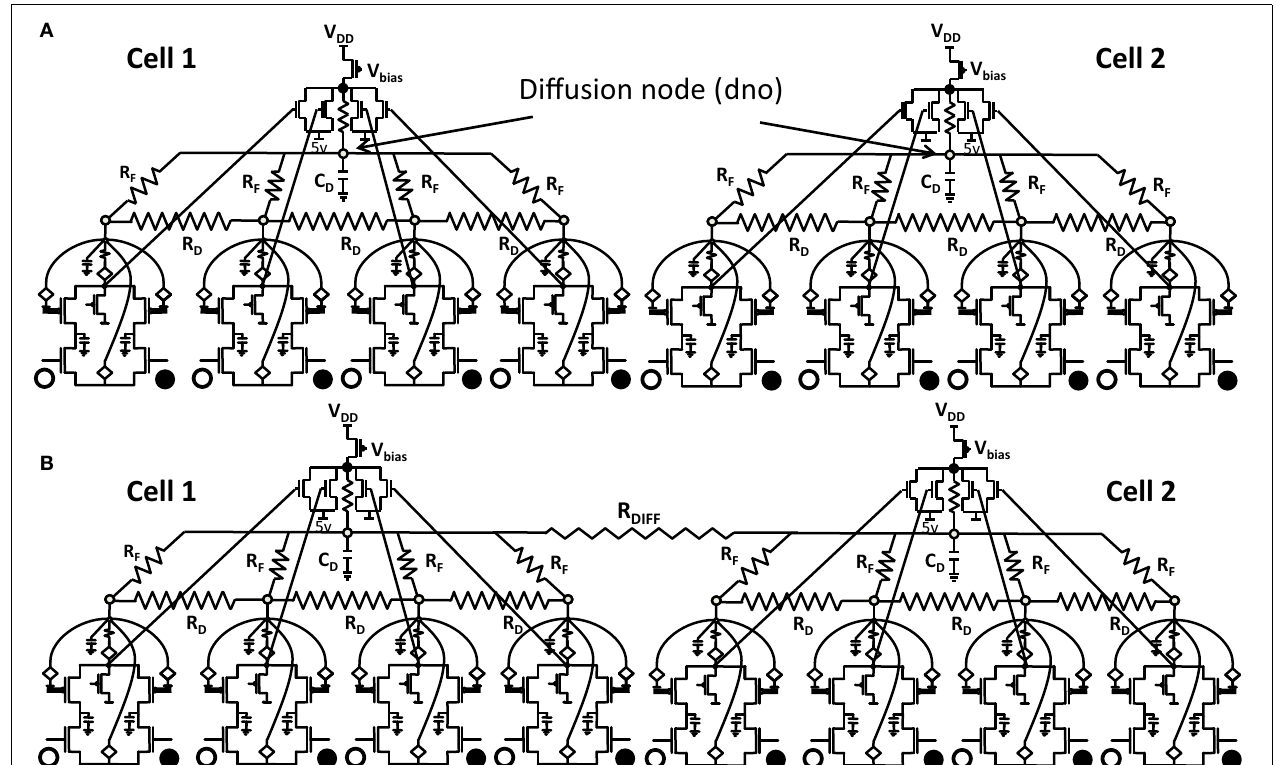
FIGURE 6.1 | Shows 2 cortical cells Cell 1 and Cell 2 with a 1 × 4 (ts-WTA) receptive field. In (A) the two cells develop independently. In (B) the two cells are connected at the diffusion node (dno) by means of